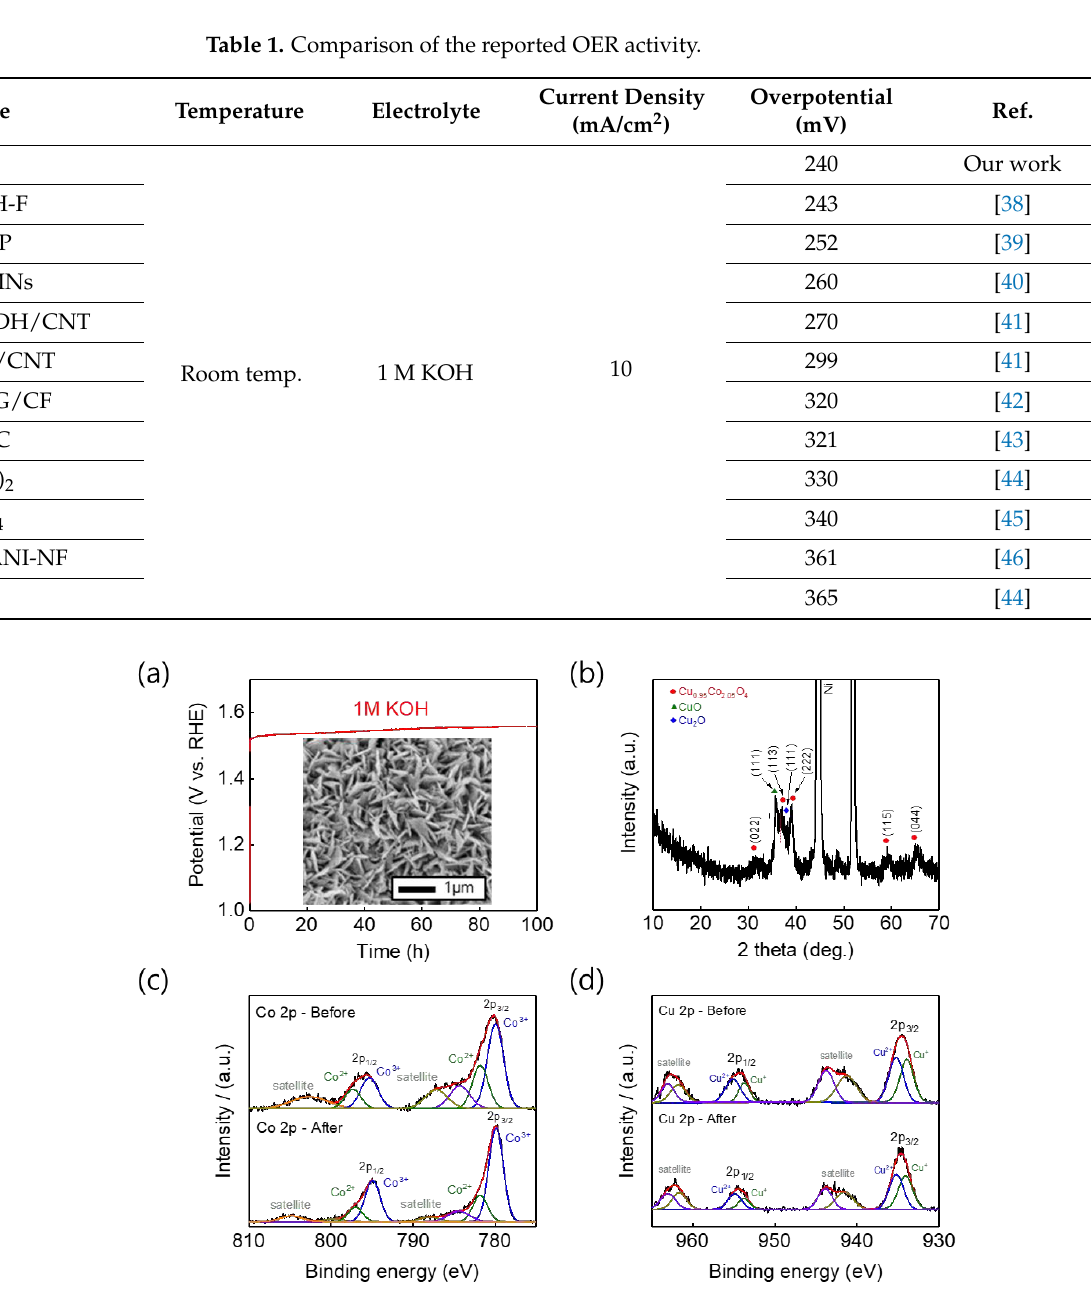
Figure 7. ( a ) Chronopotentiometry curve of CCO-250 °C at a current density of 20 mA cm −2 in 1 M KOH for 100 h. Inset show the SEM image of surface morphology for CCO after durability test. ( b ) XRD patterns, ( c ) Co 2p and ( d ) Cu 2p of CCO-250 °C after durability testing.